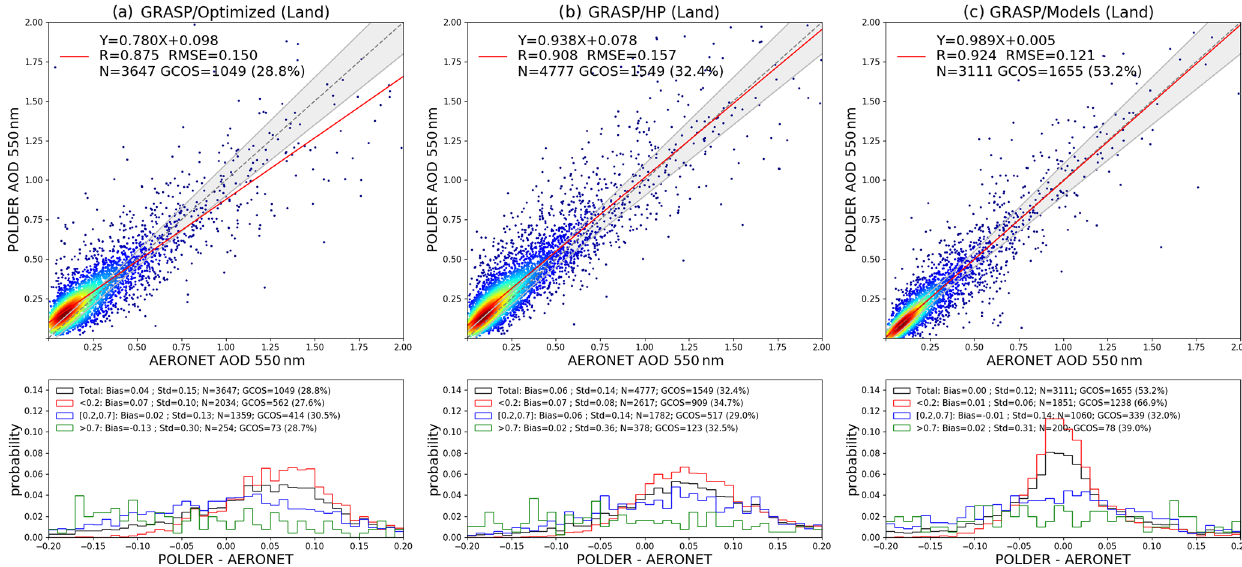
Figure 7. Validation of PARASOL/GRASP AOD at 550nm over land in 2008: (a) GRASP/Optimized, (b) GRASP/HP, (c) GRASP/Models. The gray dashed line and the red solid line are the 1 : 1 reference line and the linear regression line. The gray envelope indicates GCOS requirement: max (0.04 or 0.1AOD). The probability density functions of differences (POLDER–AERONET) are present in the lower panels. The black, red, blue and green solid lines indicate all AOD conditions: any AOD, AOD < 0.2, 0.2 ≤ AOD ≤ 0.7 and AOD > 0.7, respectively.